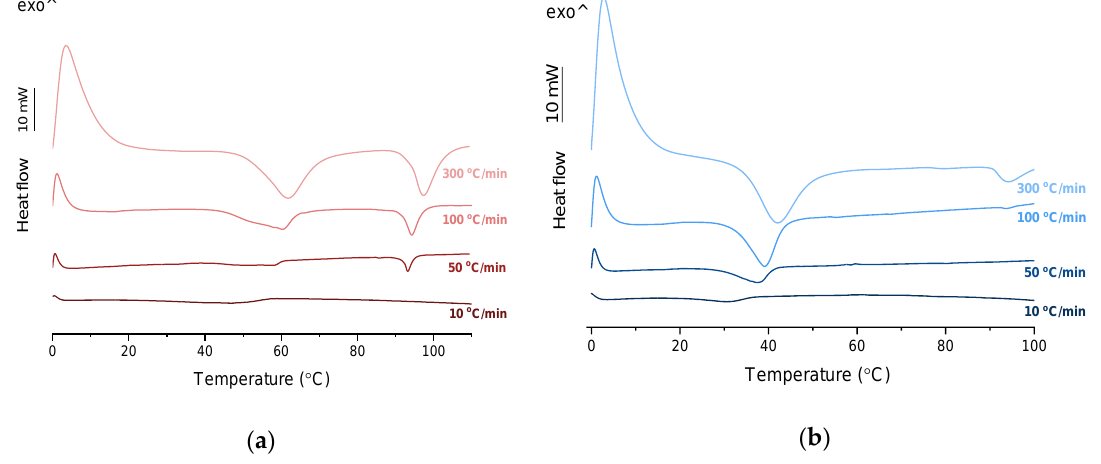
Figure 4. HSDSC thermograms of equimolar KET-LA powder mixtures heated at different rates: ( a ) KET-PRO and ( b ) KET-TET.